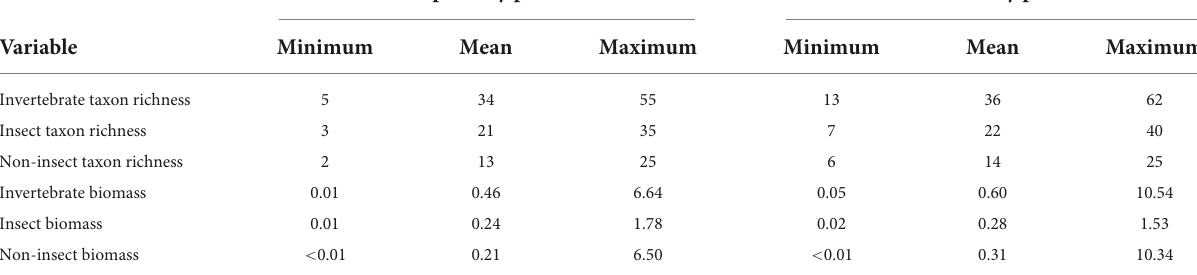
TABLE 2 Among wetland annual variability of total invertebrate, insect only, and non-insect only mean taxon richness and biomass for 16 wetlands monitored at the Cottonwood Lake study area between 1992 and 2015. Temporarily ponded Permanently ponded Variable Minimum Mean Maximum